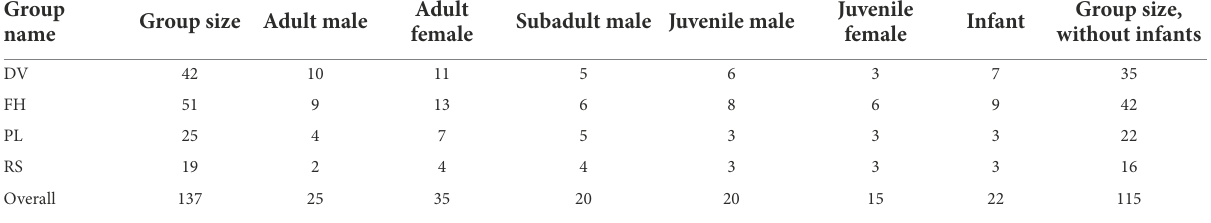
TABLE 1 Demographic composition of the four study groups of bonnet macaques during Task